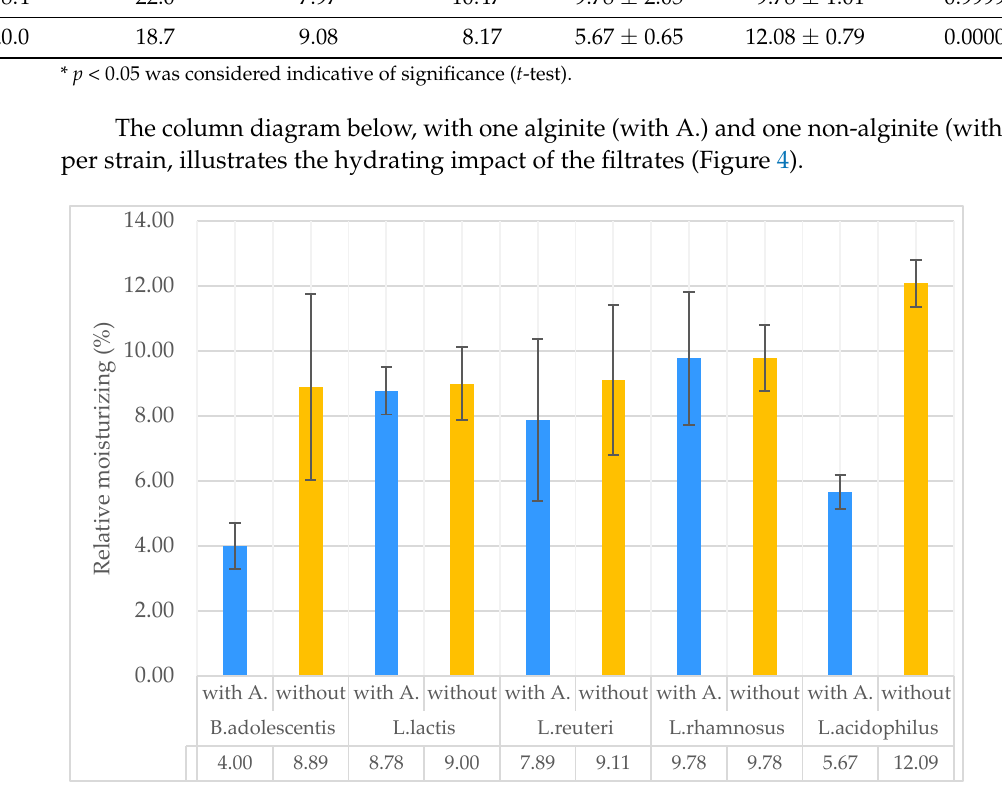
Table 1. The calculated moisturising effect of ferment filtrates according to their lactic acid concen- tration with the measured results. Lactic Acid Conc.